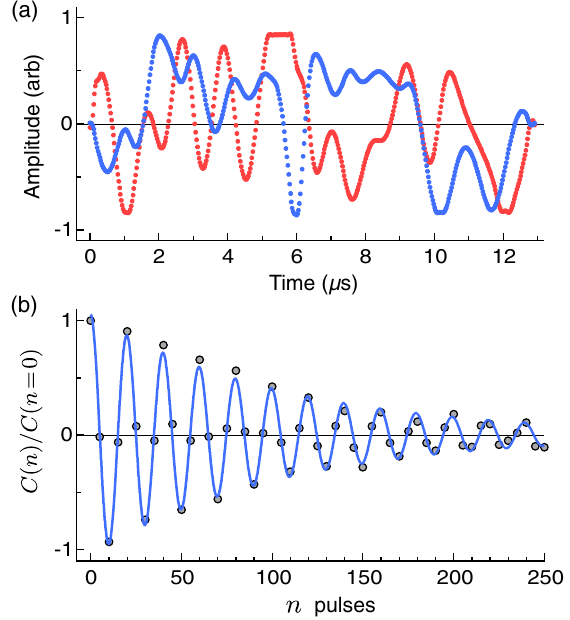
FIG. 2. Repeated Ω ð π /2 Þ x measurements. (a) Calculated Ω ð π /2 Þ waveform. The two quadratures a 1 ð t Þ (red line) and a 2 ð t Þ (blue line) correspond to the modulation envelope of the 13- μ s-long OCT-AHT pulse. The applied pulse is given by a ð t Þ ¼ a frequency, and the phase α determines the direction of the effective field in the rotating frame. (b) Normalized spin correlation measurements. Here, C ð n Þ is the measured z -axis correlation [Eq. (1)] as a function of the number n of sequential applications of the Ω ð π /2 Þ x pulse in the encoding sequence. The data are fit to the functional form cos ð π n /10 Þ exp ð − cn Þ . From the fit, we find c ¼ 0 . 01